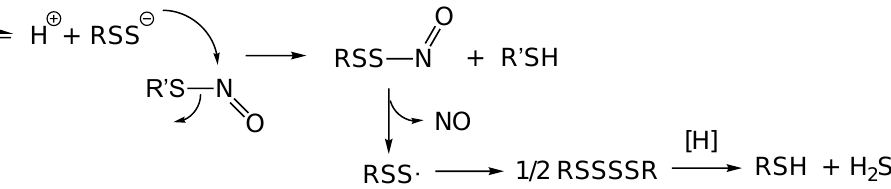
Figure 4. The reaction of RSSH with R’SNO to give NO and, after biological reduction ([H]), RSH and H 2 S.